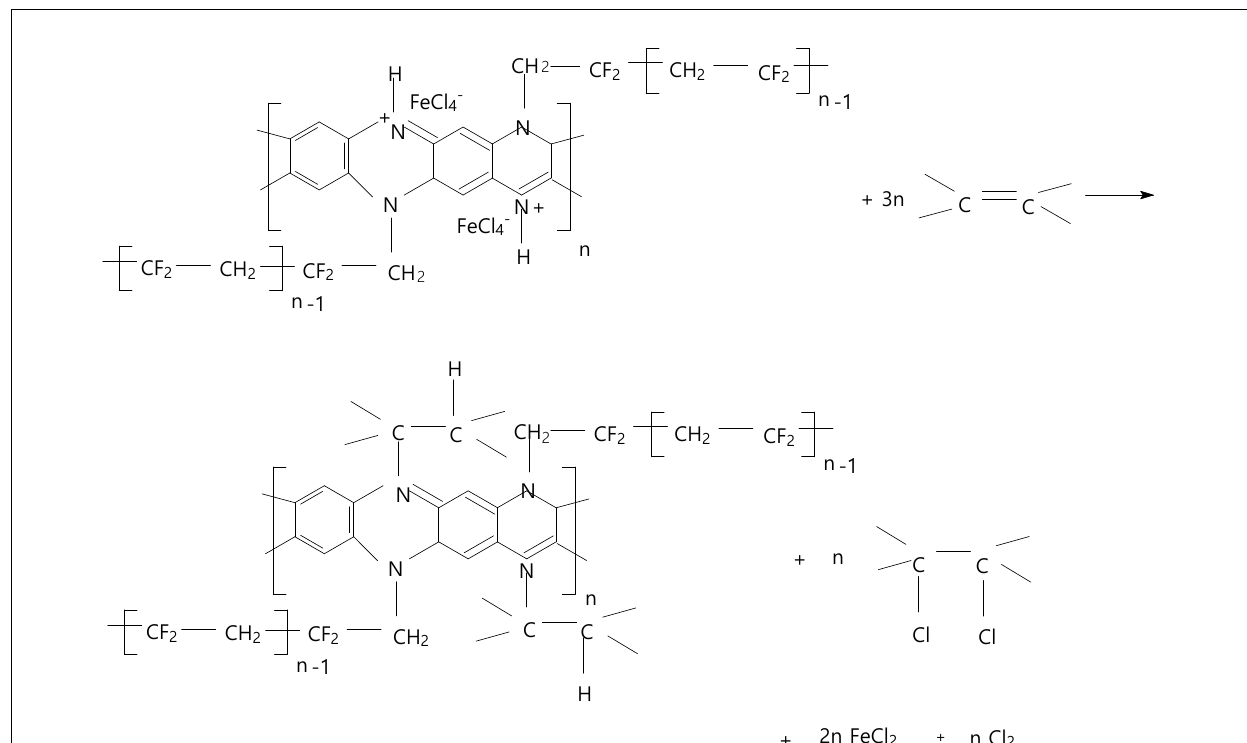
Scheme 2. The chemical reaction of POPD doped with FeCl 4 – ions with DWNTs.